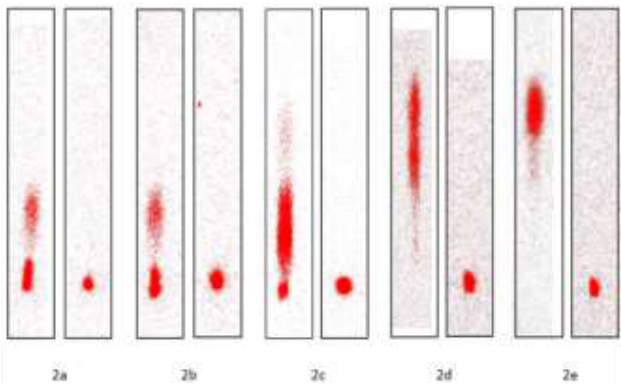
Figure 6. ITLC analyses of 2a – e radiobioconjugates after incubation in human serum at 37 C for 24 h.